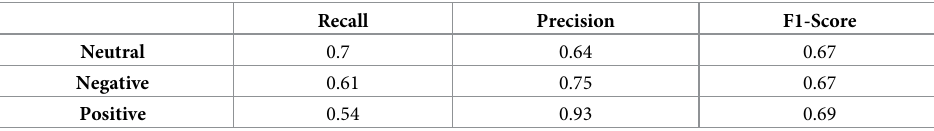
Table 1. Machine learning metrics. Different metrics of the sentiment analysis